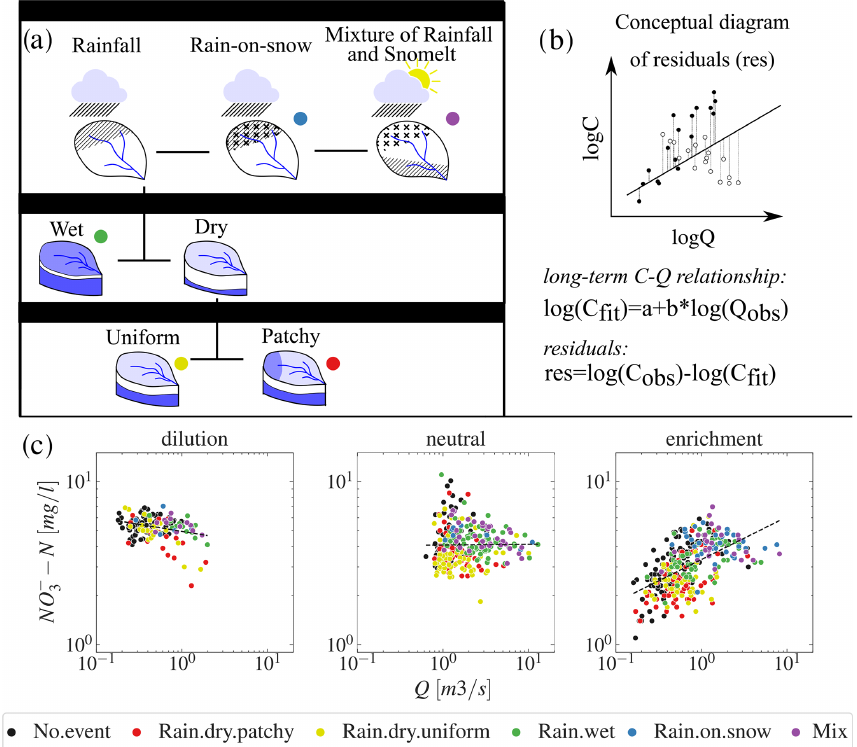
Figure 3. (a) Hierarchical scheme for event classification (modified from Tarasova et al., 2020; classification criteria are provided in Ta- ble S1). Colored dots located next to the five different event types indicate their markers. (b) C obs and Q obs are observed concentration and discharge, Cfit is the nitrate concentration estimated from fitting the long-term C – Q relationship with a linear relation in log–log space, and res is the residual value. (c) C – Q plots for three different catchments attributed to different long-term nitrate export patterns based on the log C –log Q slope b , i.e., dilution ( b < − 0.1, the Würm River in Pforzheim), neutral ( b ∼ 0, the Wupper River in Opladen) and enrichment ( b > 0.1, the Naab River in